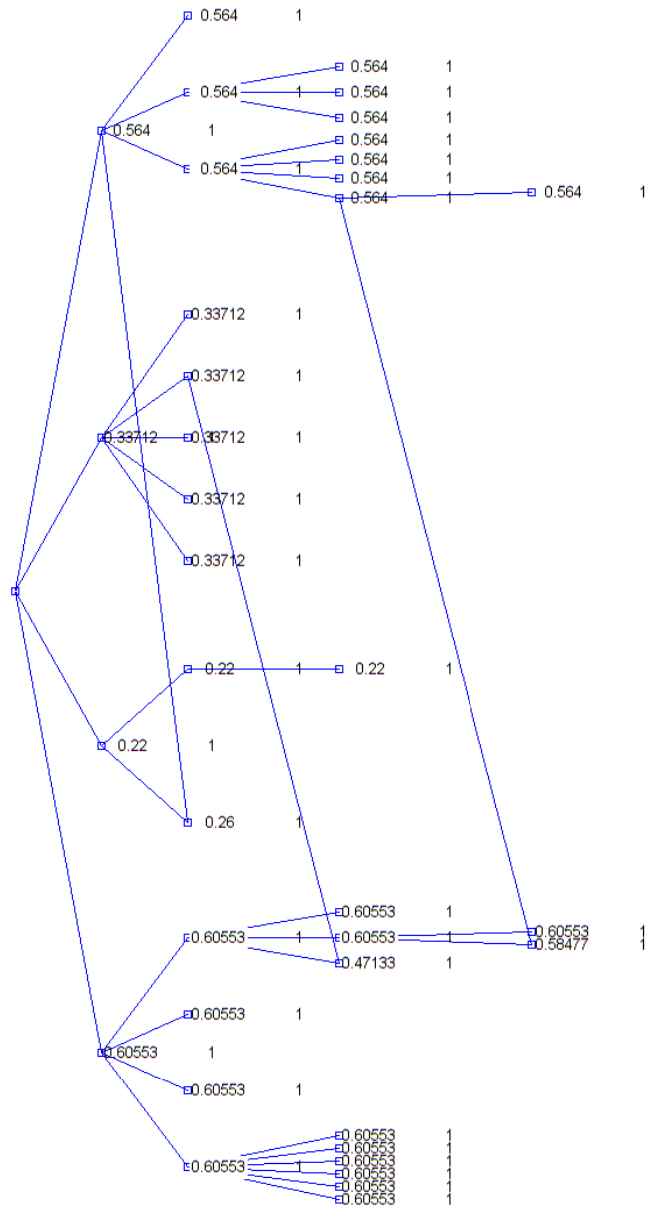
Figure 4. Initial user profile in first method Figure 5. Updated user profile in first